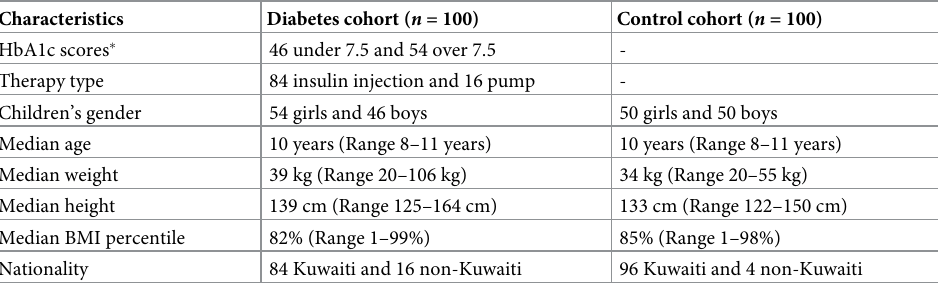
Table 1. Demographic and clinical characteristics of children.